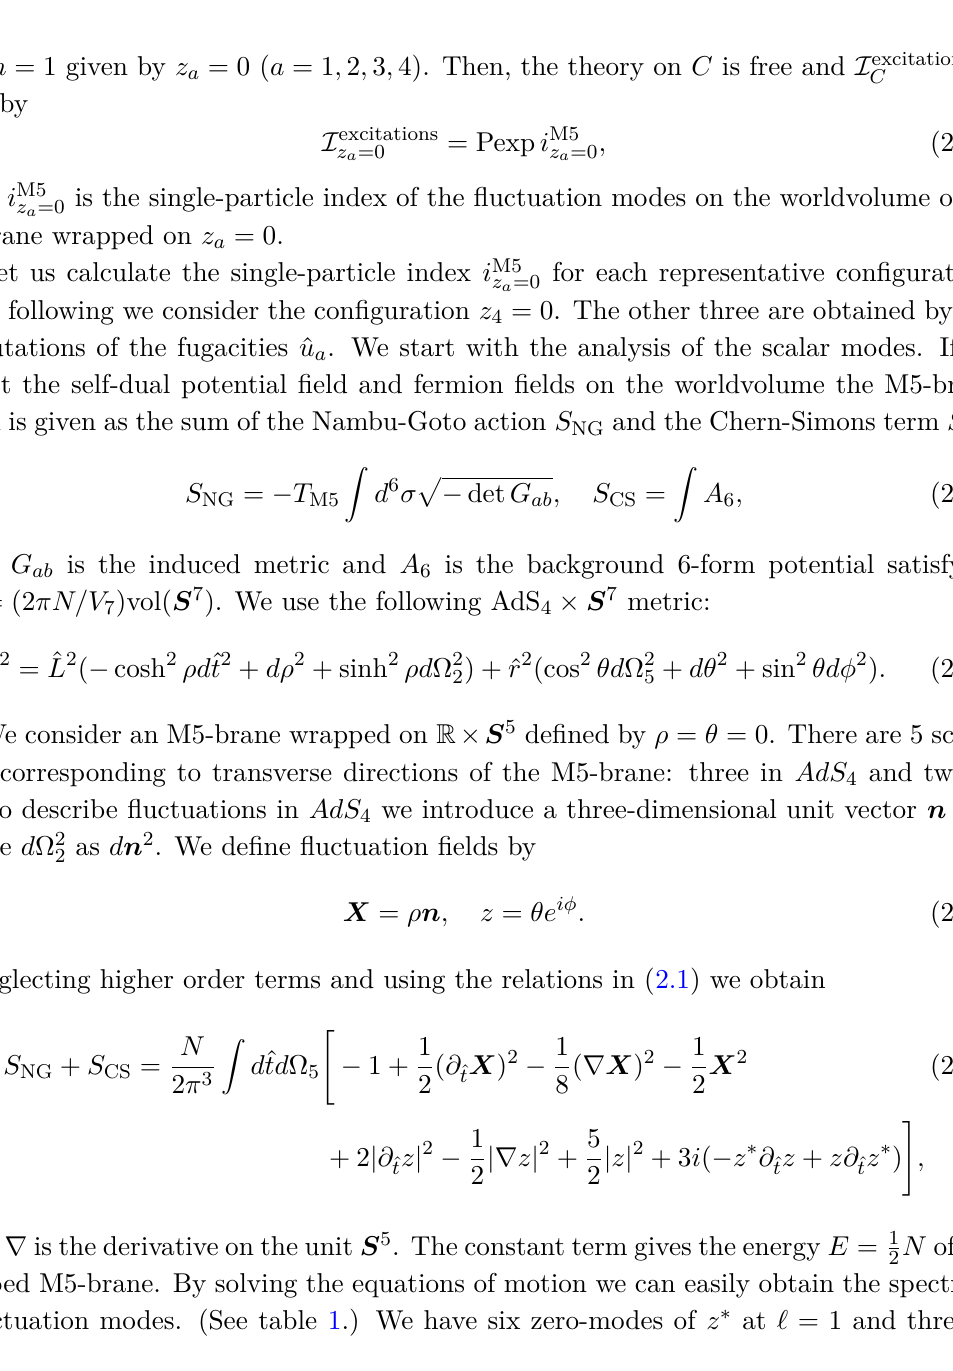
Table 1 . Scalar fluctuation modes on an M5-brane wrapped on z 4 = 0 . ‘ = 0 , 1 , 2 , . . . is the angular momentum on S 5